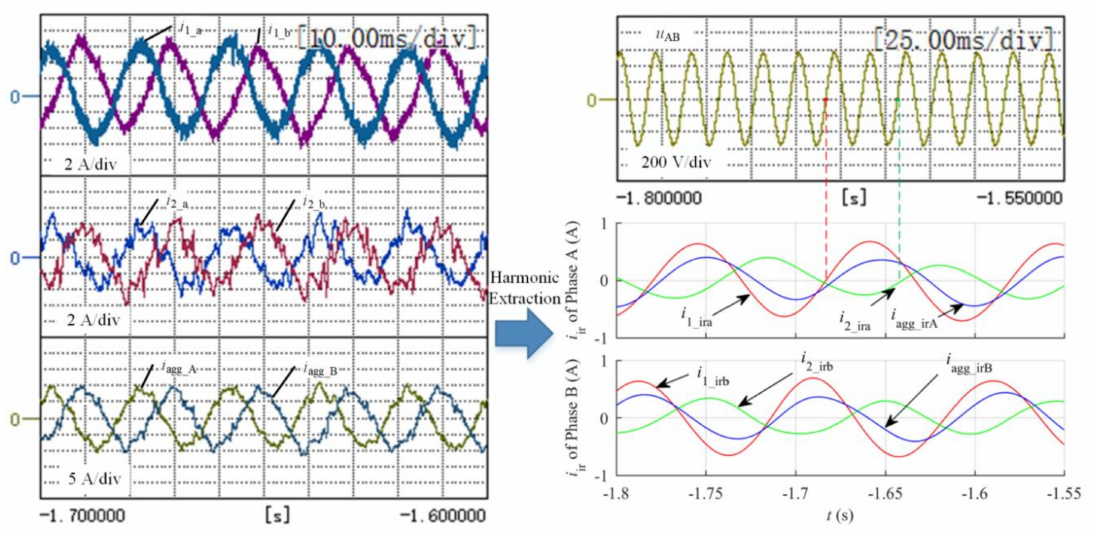
Figure 14. Actual negative sequence 10 Hz